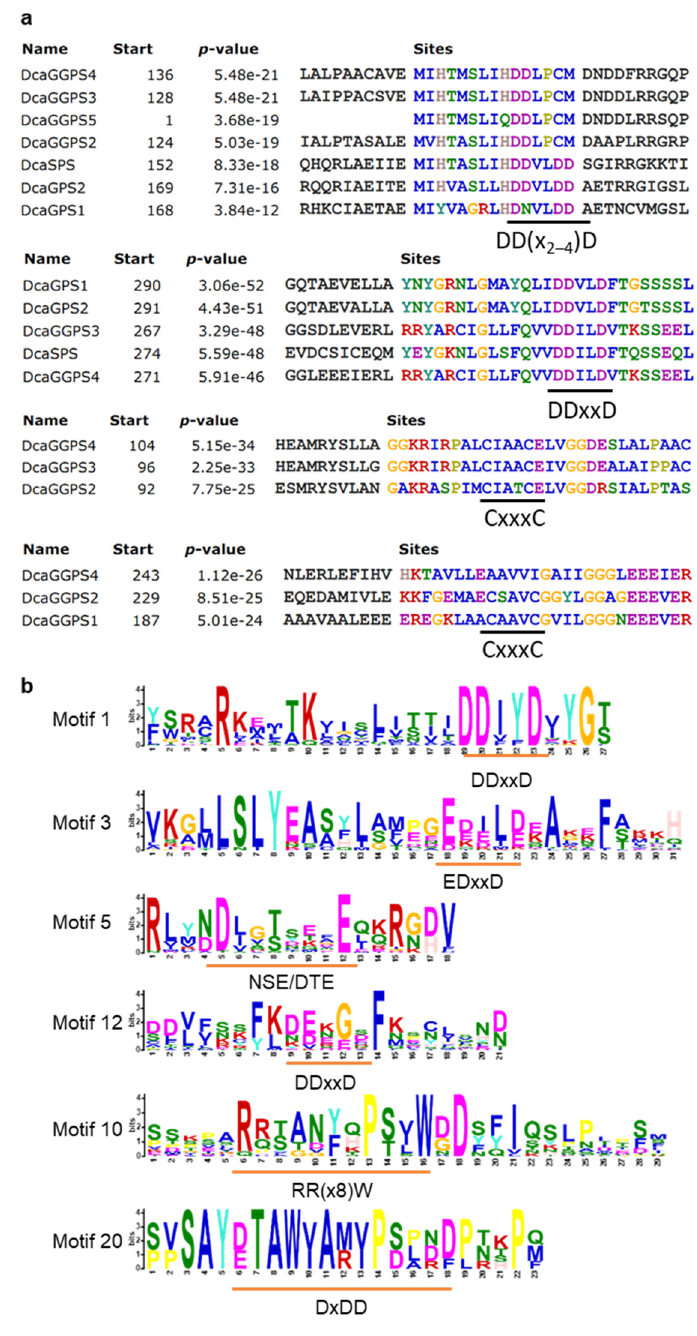
Figure 4. Domain organization of DcaPS-TPS. ( a ) The conserved motifs of DcaPSs. ( b ) The conserved motifs of DcaTPSs. Asp-rich motifs (DDxxD) are found in DcaPS-TPS, where ‘x’ is any amino acid.